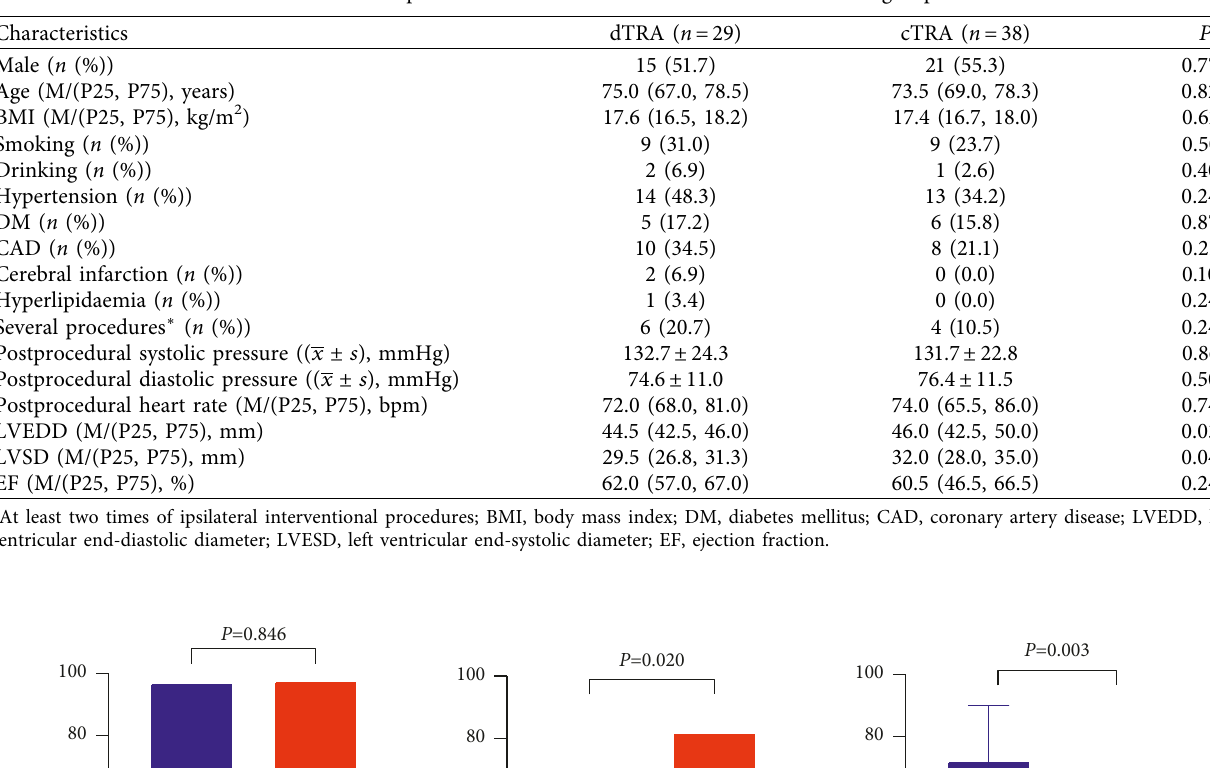
Table 1: Comparison of baseline characteristics between the two groups.